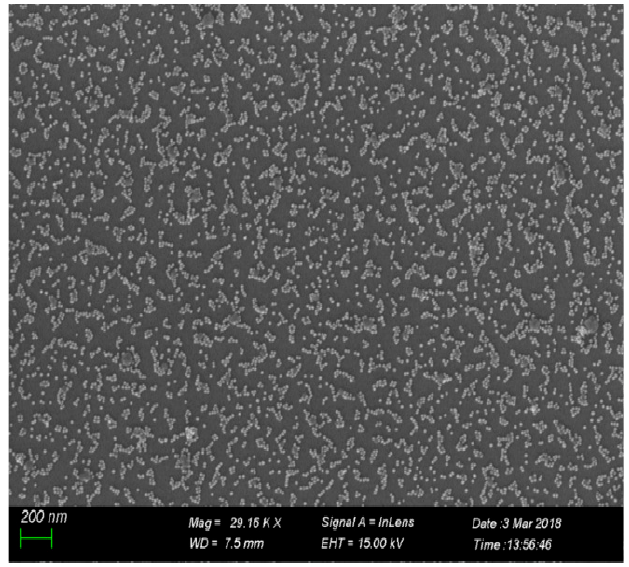
Figure 3. SEM image of the AuNPs, describing morphology and size.